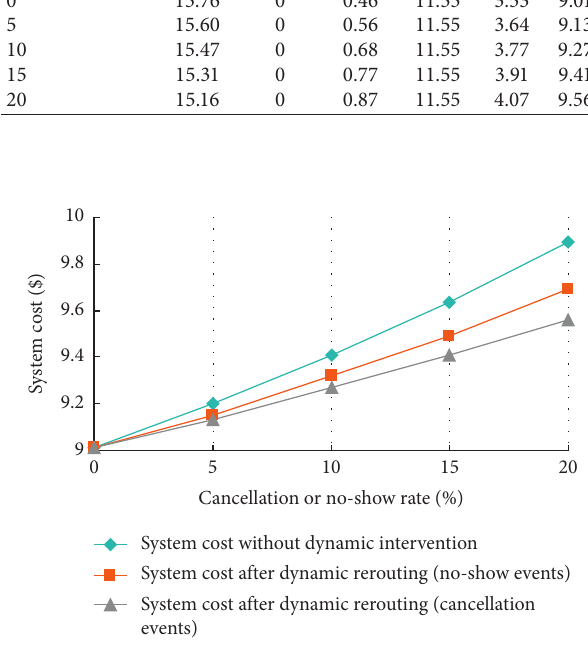
Figure 4: System cost with and without dynamic